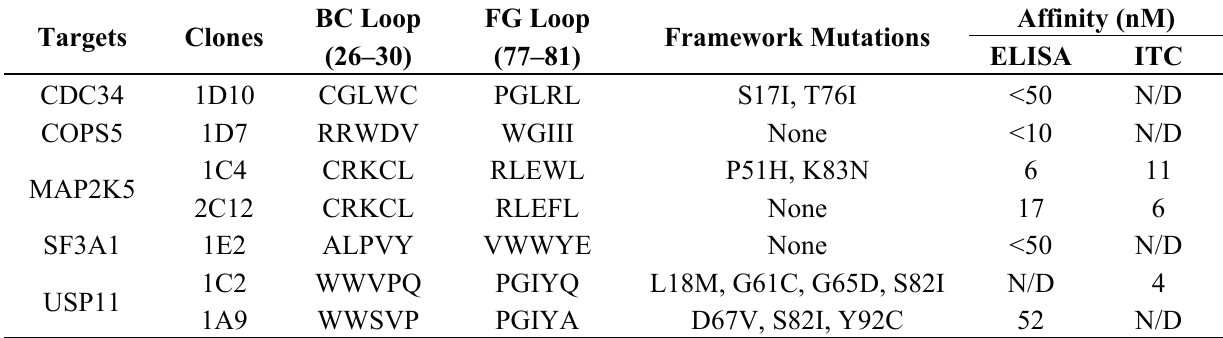
Table 2. Output sequences and affinities of clones after affinity maturation.